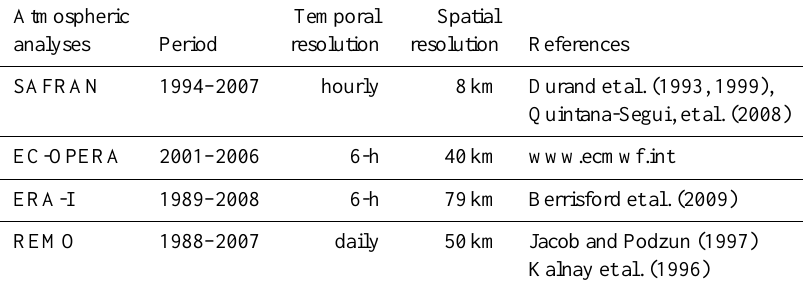
Table 2. Summary of atmospheric